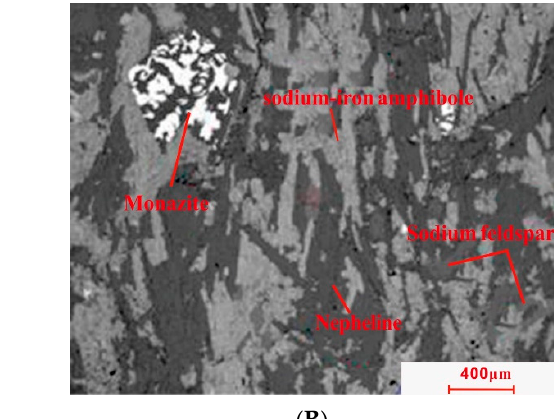
Figure 5. Support vector machine schematic.